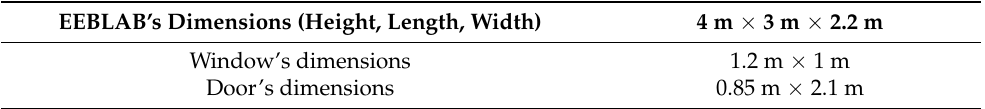
Table 2. Dimensions of the EEBLAB and its components.